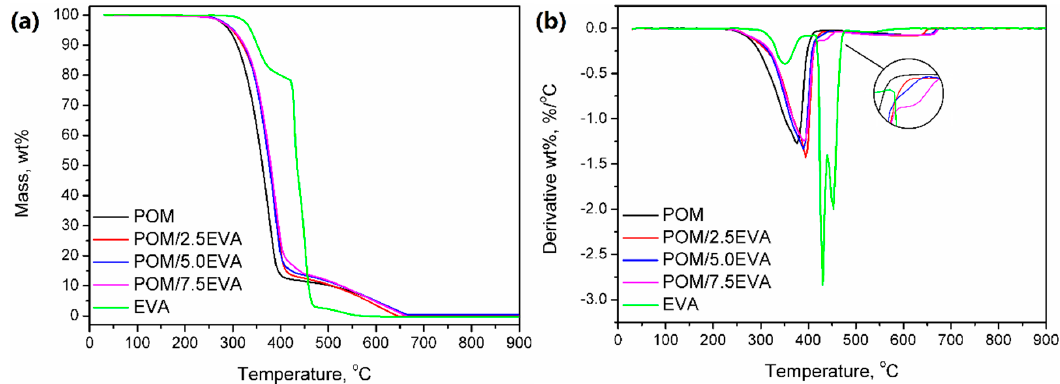
Figure 5. ( a ) Thermal stability and ( b ) differential thermogravimetric curves for prepared samples.